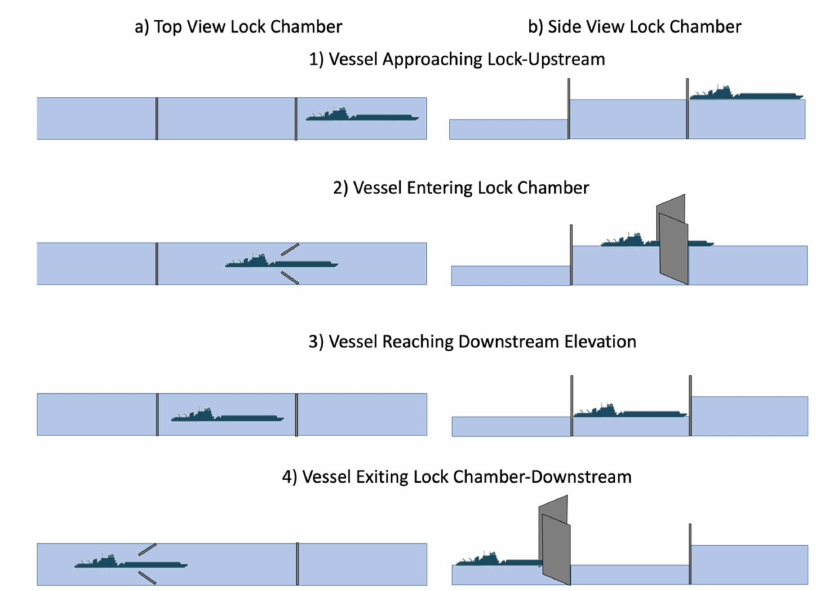
Figure 3. Vessel moving through lock gates, from downstream to upstream.